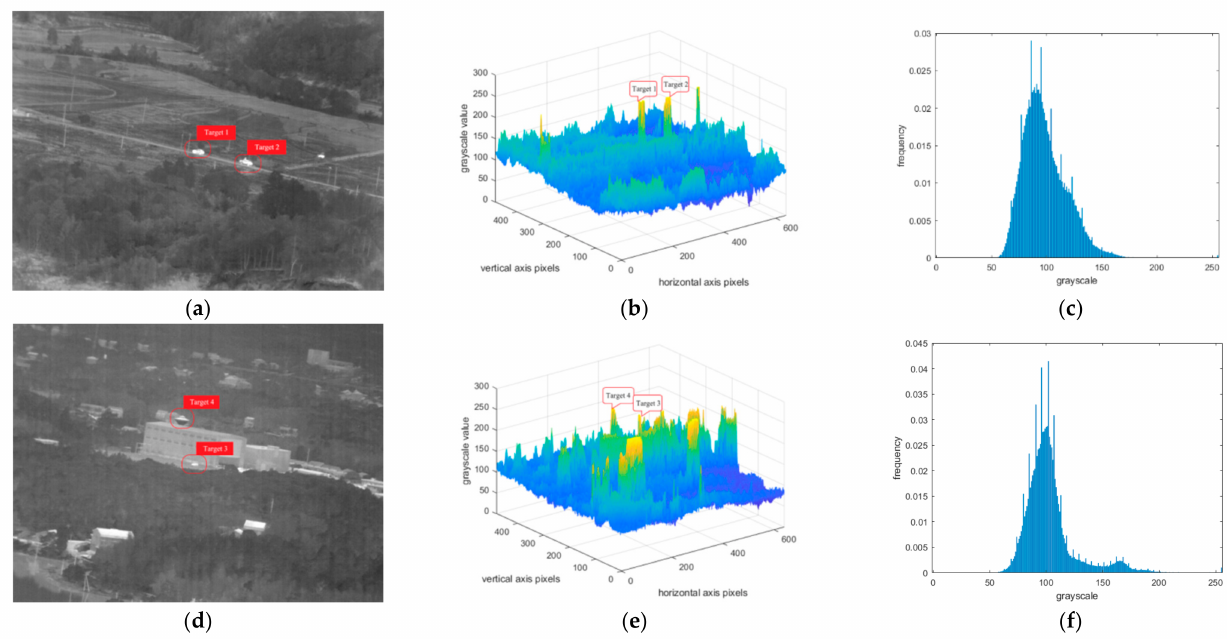
Figure 2. Image Characteristic analysis. ( a ) Original image. ( b ) 3D grayscale plot. ( c ) Grayscale histogram. ( d ) Original image in complex environment. ( e ) 3D grayscale plot. ( f ) Grayscale